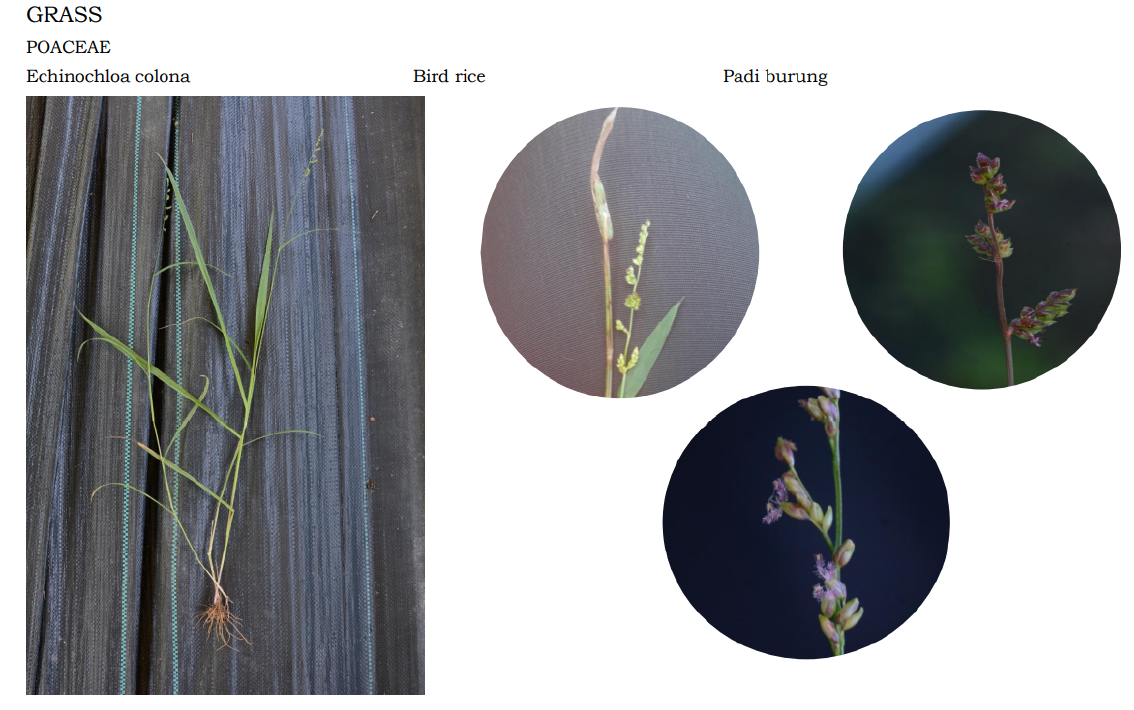
Figure A3. Grass Poaceae: Eleusine indica.